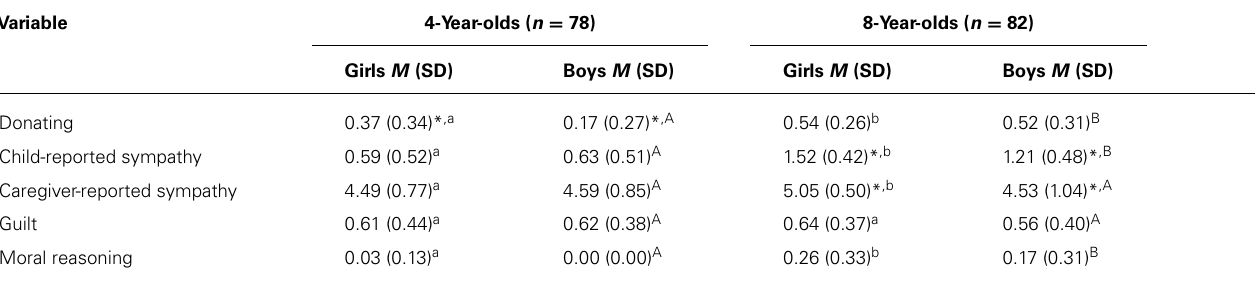
Table 2 | Means and standard deviations of study variables by age group and gender.